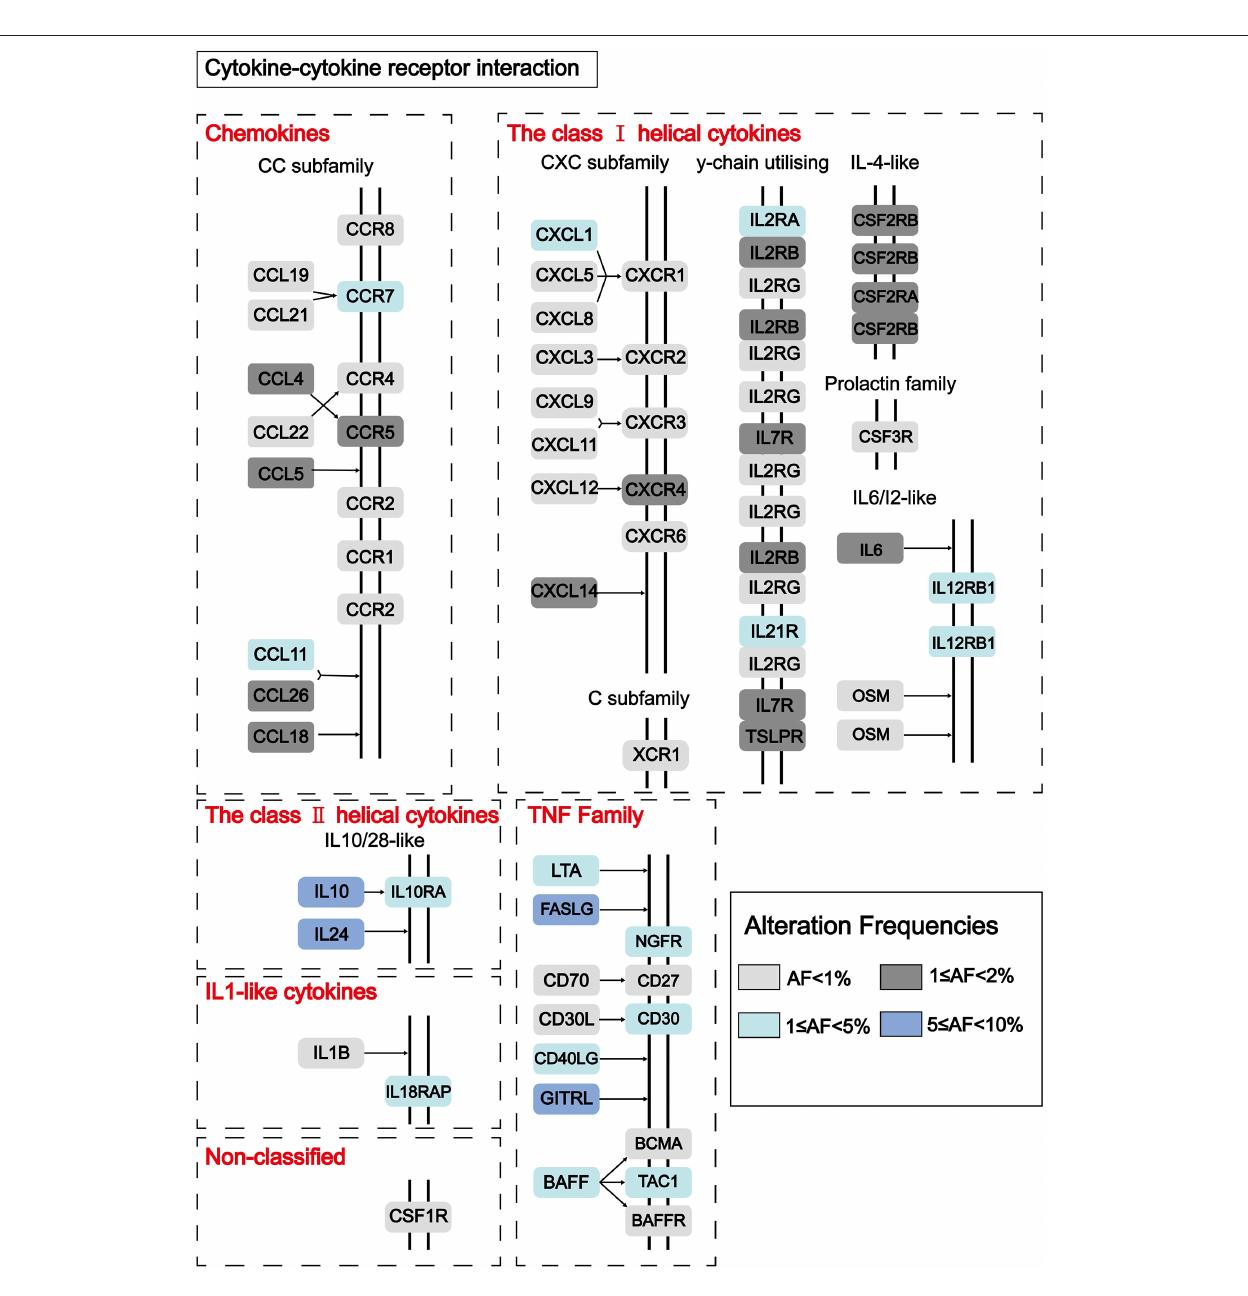
FIGURE 3 | Pathway diagram showing the interaction of DEGs in the cytokine–cytokine receptor interaction pathway. Alteration frequencies of each gene were represented by the color intensity. cells and was highly correlated with 12 immune cells ( R > 0.3), including T-cell co-inhibition, CD8 + _T cells, check-point, inflammation-promoting, TIL, Th1 cells, APC co-inhibition,